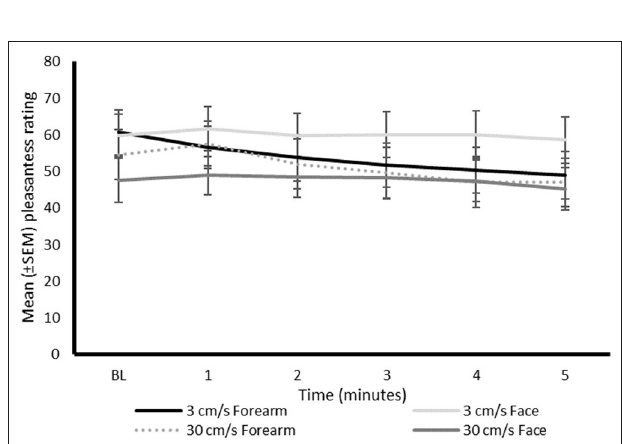
FIGURE 5 | Mean unpleasantness ratings (0–100 NRS) during continuous stroking on the differing regions at the differing time intervals. BL, baseline; NRS, numerical rating